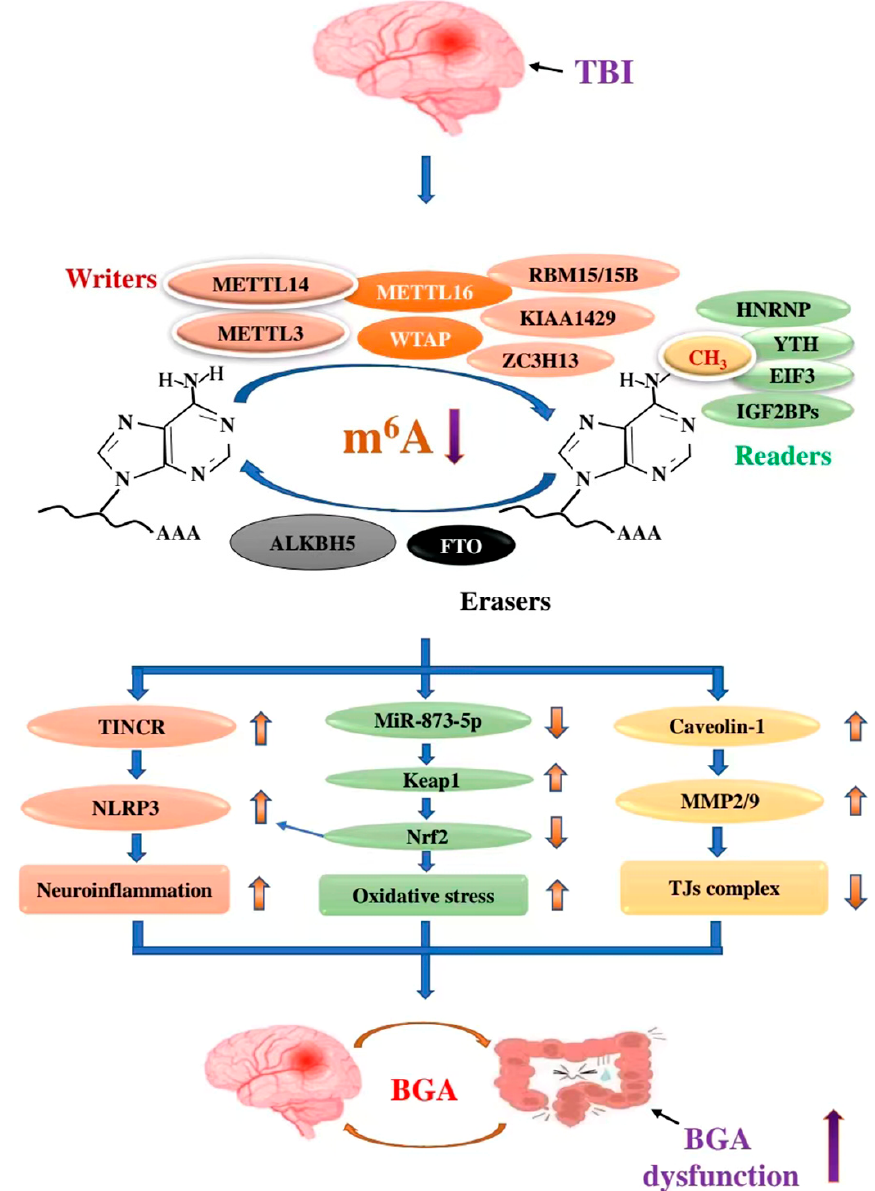
Figure 8. The possible pathways of m 6 A regulating the pathological process of BGA after TBI: TBI causes the downregulation of m 6 A, which is involved in TBI-induced BGA disfunction via METTL14/TINCR/NLRP3, METLL3/miR-873-5p/Keap1/Nrf2 signalling, and FTO/Caveolin- 1/MMP2/9 pathways.